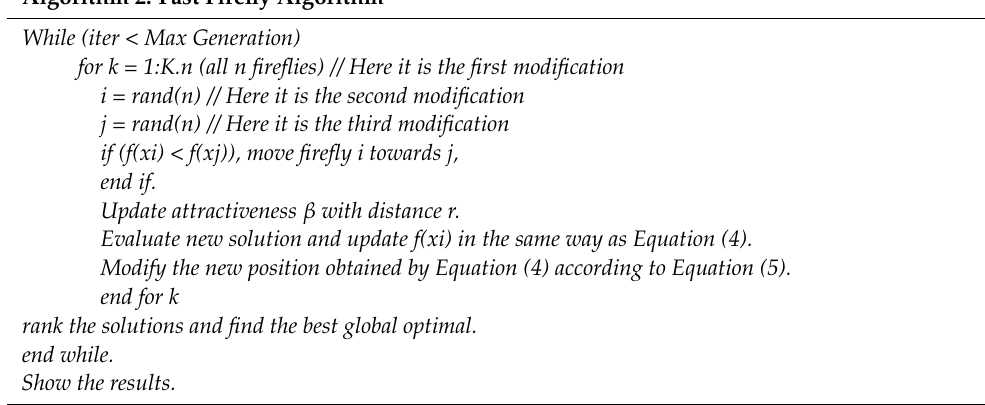
Algorithm 2. Fast Firefly